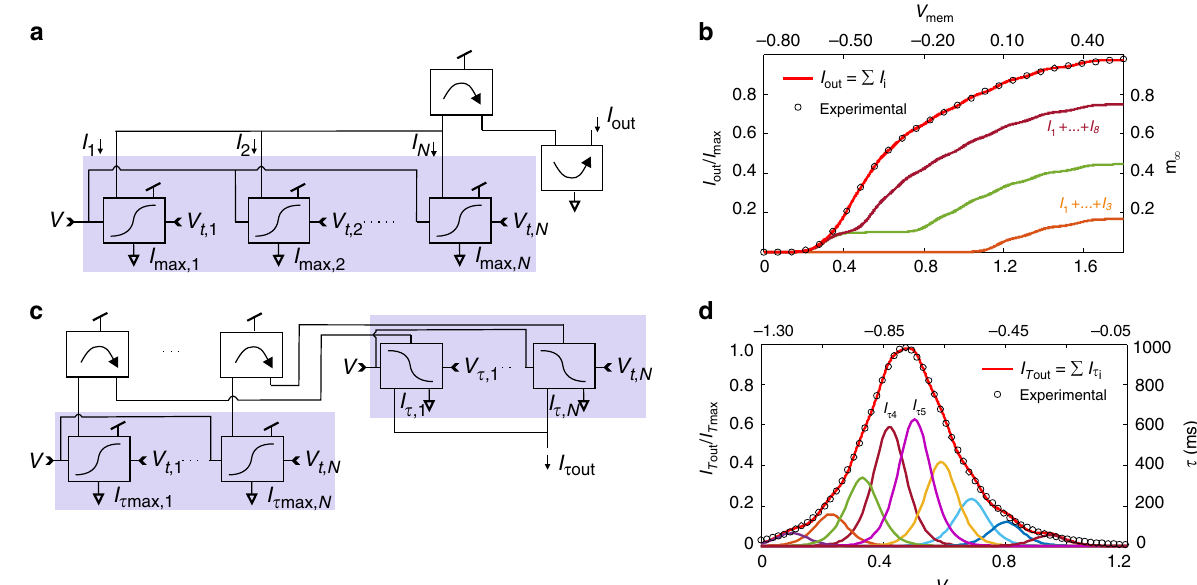
; ¼ ; I . b Activation curve of the A max ; 1 max ; N (full red line). The output out V Þ . c Circuit interpolating the activation/inactivation kinetics by 1 ð